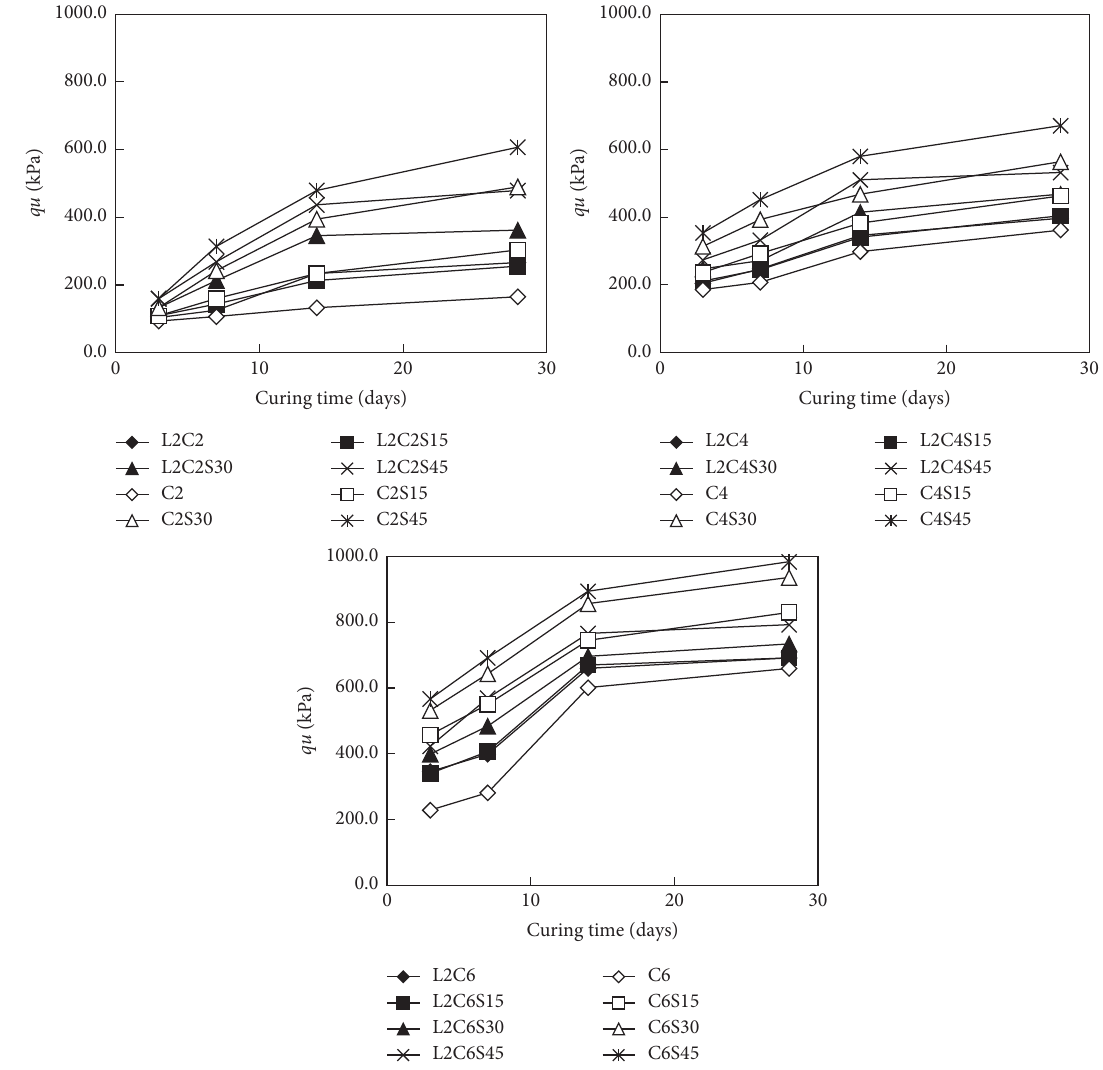
Figure 3: Strength development with curing Table 4: Compactness of representative symbols.